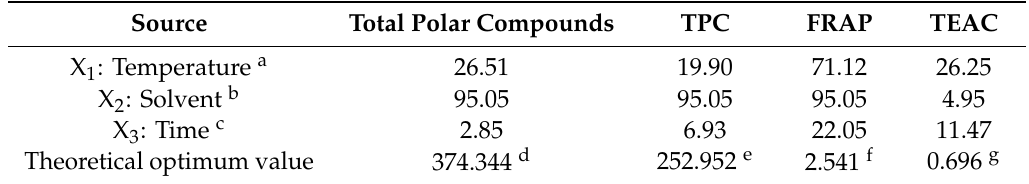
Table 8. Values of the independent conditions to optimize the value of the response variables in L. citriodora . Response variables: Total Polar Compounds, TPC, FRAP and